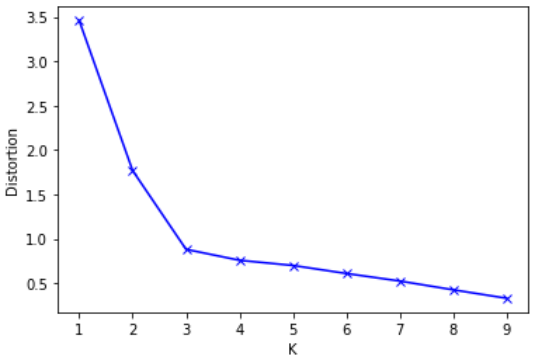
Figure 2. Optimal eps value for DBSCAN.